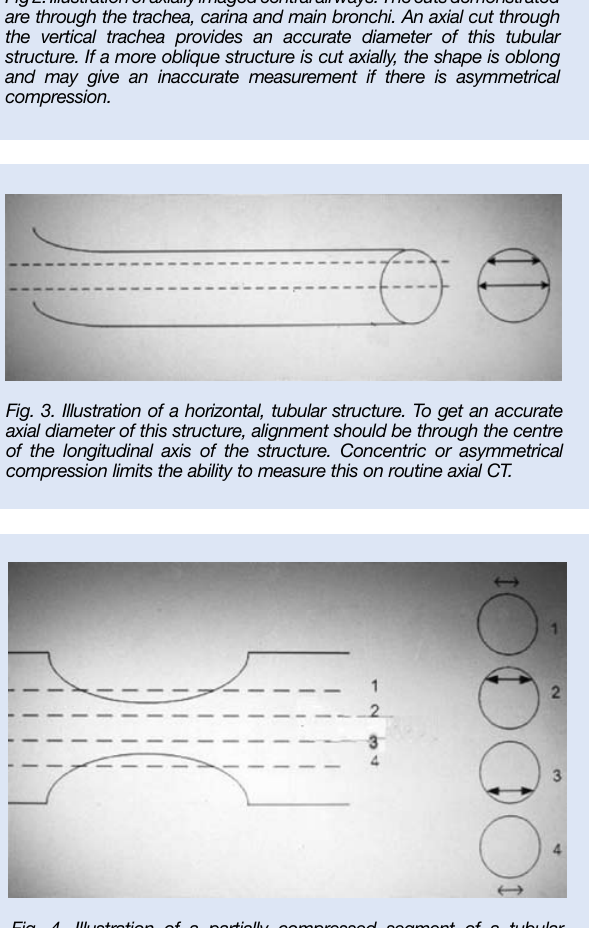
Fig. 4. Illustration of a partially compressed segment of a tubular structure. There is a higher possibility that cuts through the compressed segment might not be through the centre; therefore, an inaccurate diameter will be measured. There are at least 2 slices that may give a realistic diameter on the non-compressed segment and none in the compressed segment in this theoretical